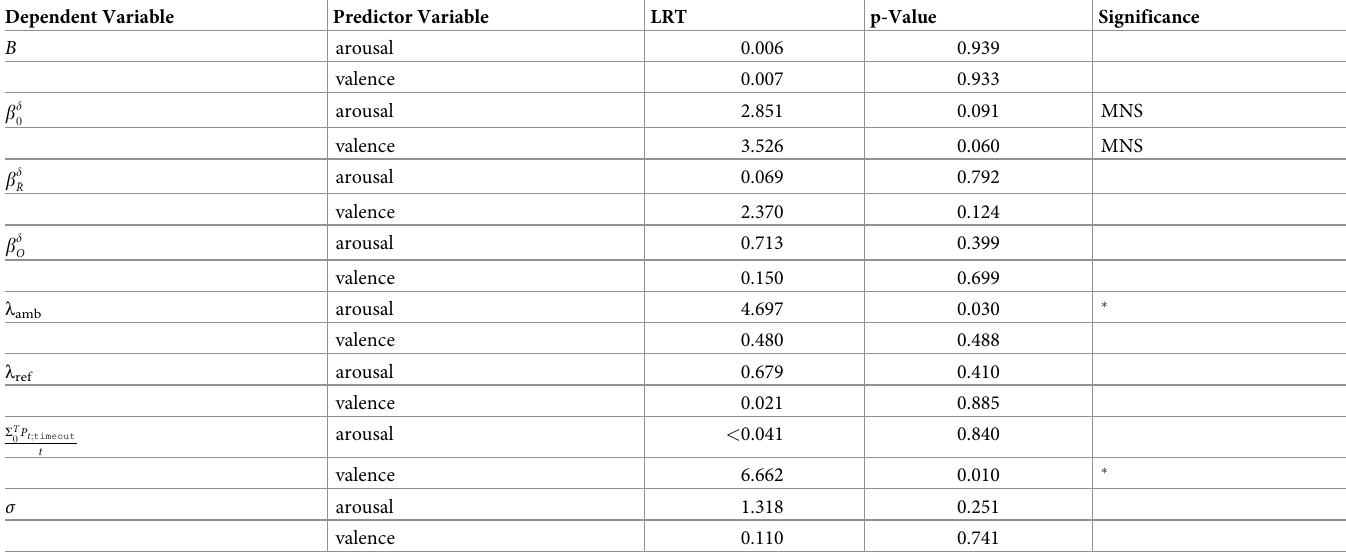
Table 1. Results of the statistical analysis of the estimates of parameter estimates.